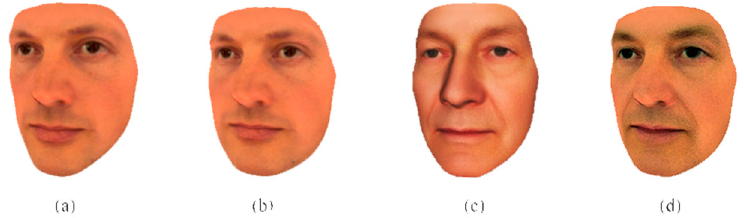
Figure 2. ( a ) Original input three-dimensional (3D) face: f ( j ) ; ( b ) 3D face inferred from the transformation function: ψ ( f ( j )) ; ( c ) 3D face template at the target age: T p ( i ) ; and ( d ) the aged 3D face: F ( i ) .